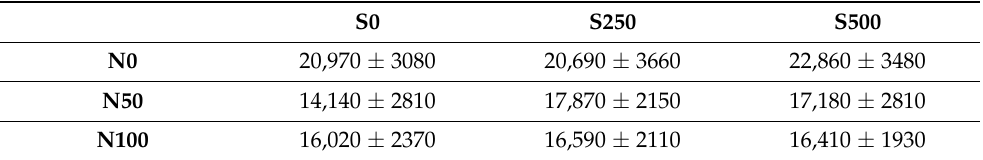
Table 1. The average value and the standard deviation for the Young’s modulus E of PAA gels at each condition.